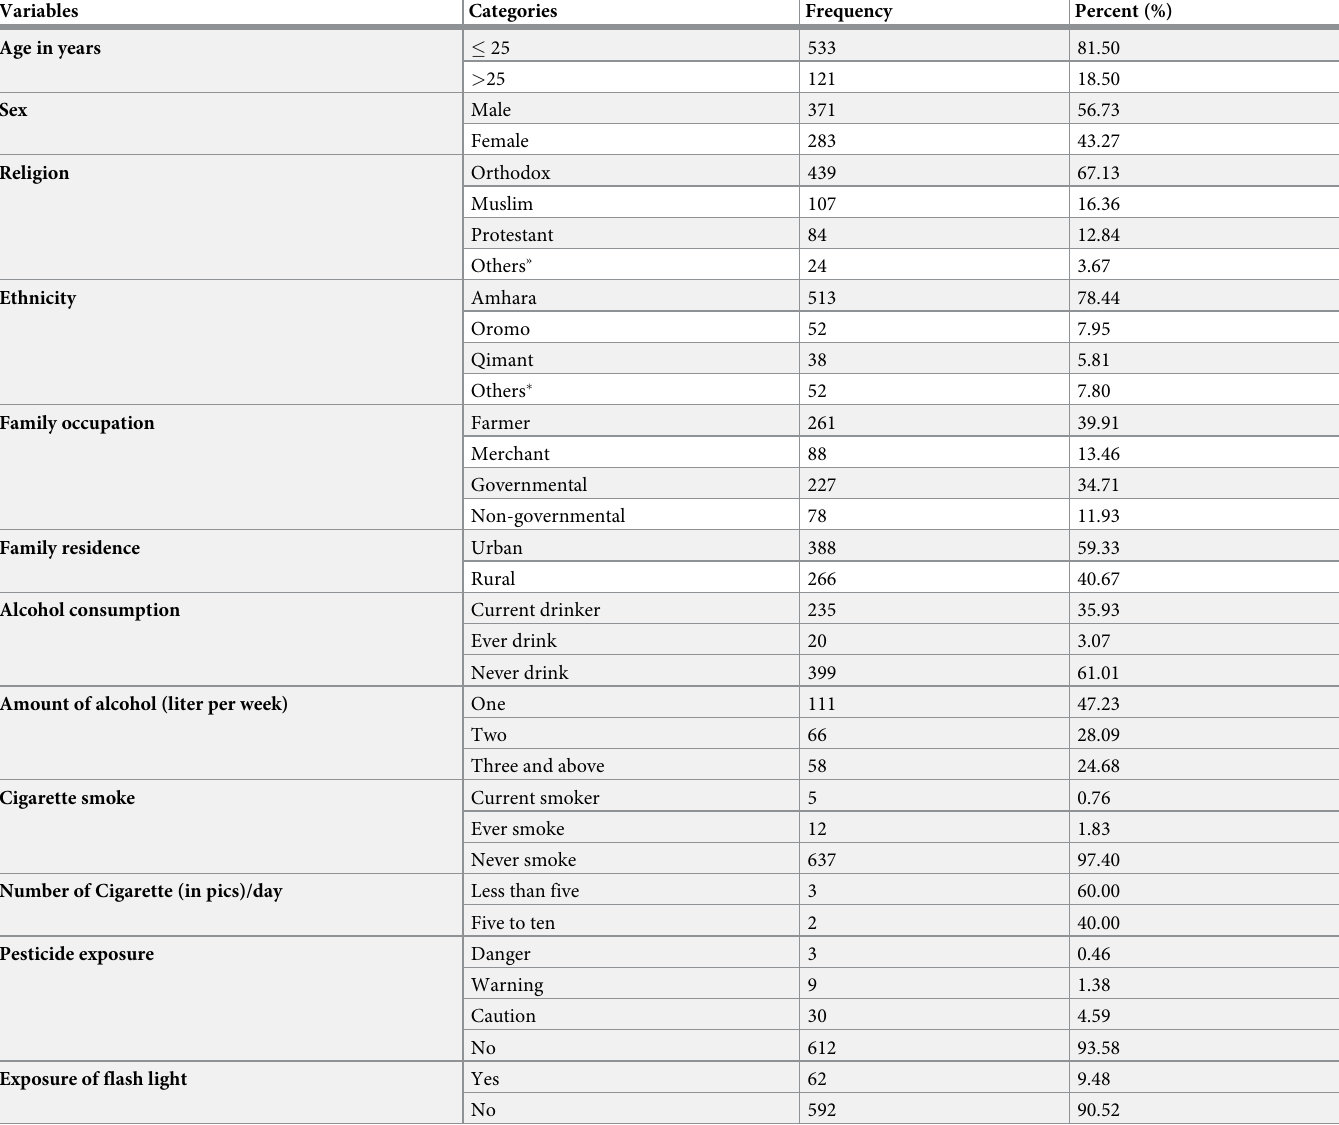
Table 2. Socio-demographic, behavioral and environmental characteristics of the study participants, College of Medicine and Health Sciences, University of Gon- dar, Northwest Ethiopia, 2020 (n = 654).